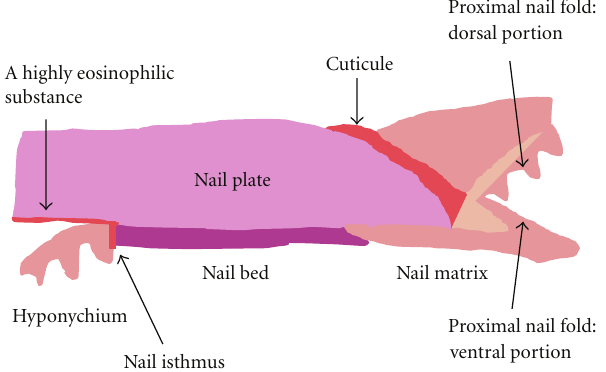
Figure 4: An appearance of an ectopic nail in a 7-year-old Japanese man.